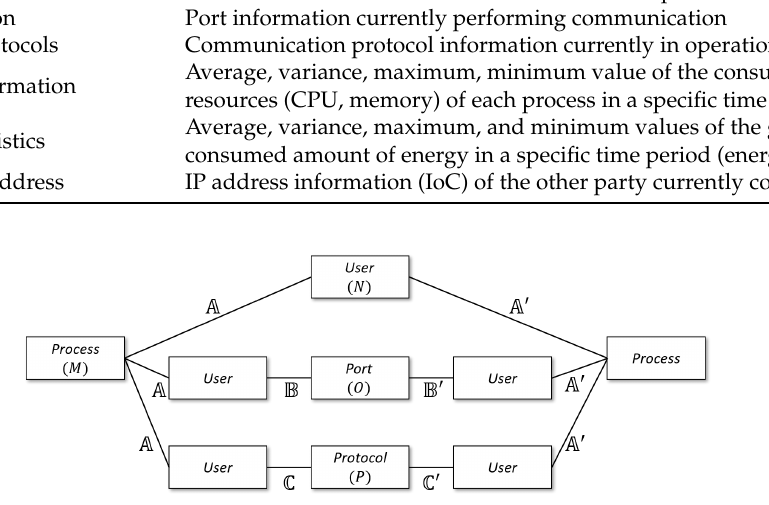
Figure 3. Information network using local threat